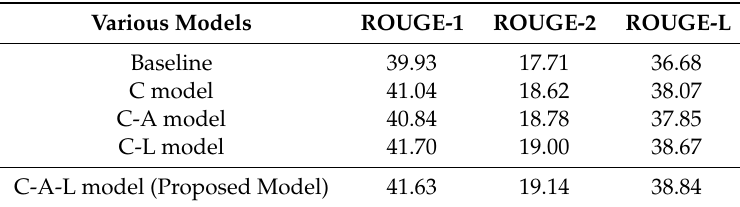
Table 4. ROUGE F1 scores of models containing a subset or all of the proposed